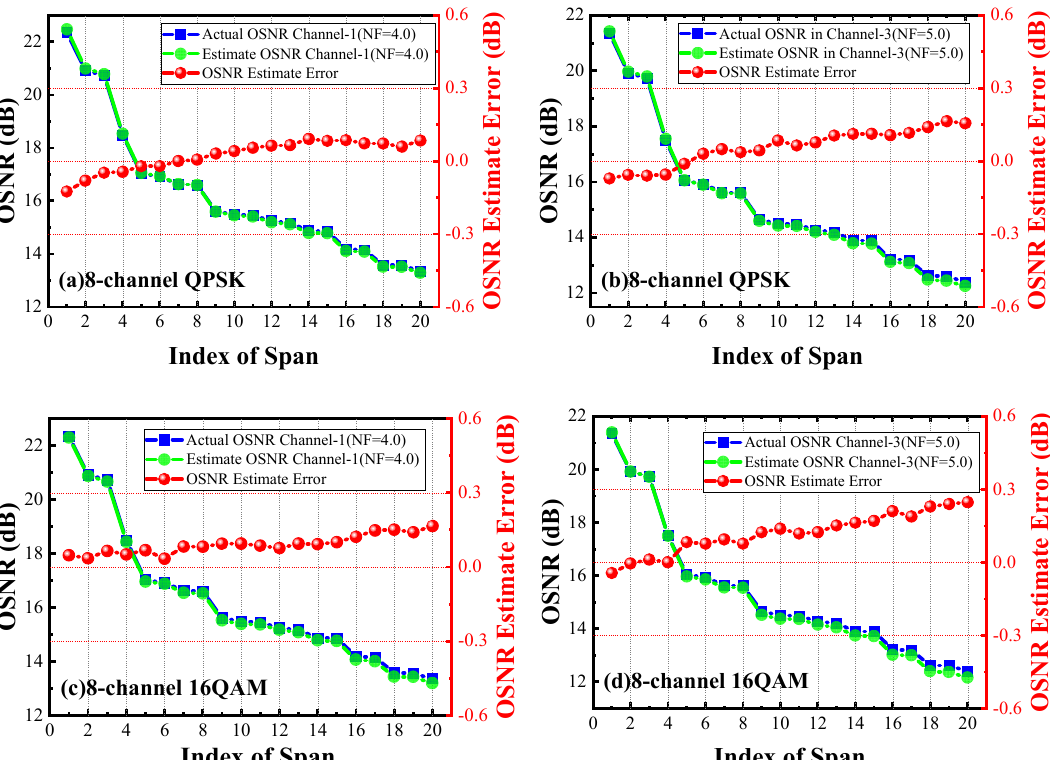
Figure 8. Result of OSNR estimation and corresponding error under [20–100 km] unequal-length span in ( a , b ) QPSK and ( c , d ) 16QAM systems.